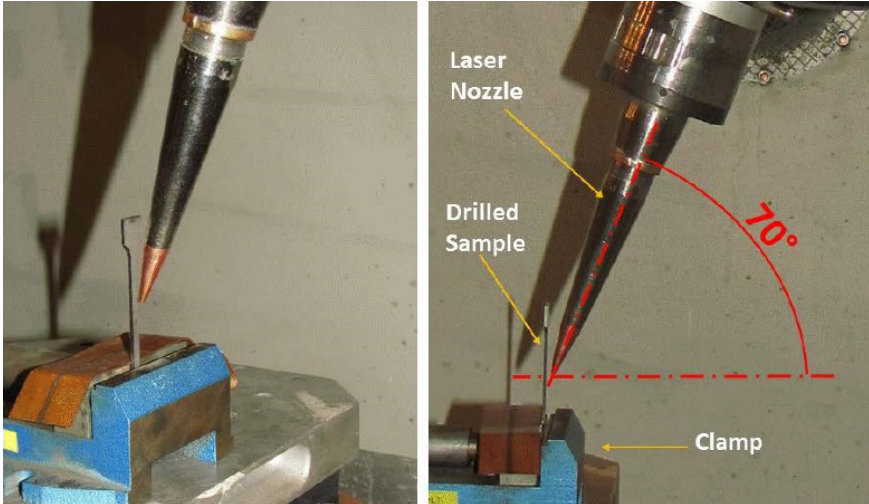
Figure 3. Clamped experimental sample to be drilled by laser beam—top left picture; laser nozzle adjustment.